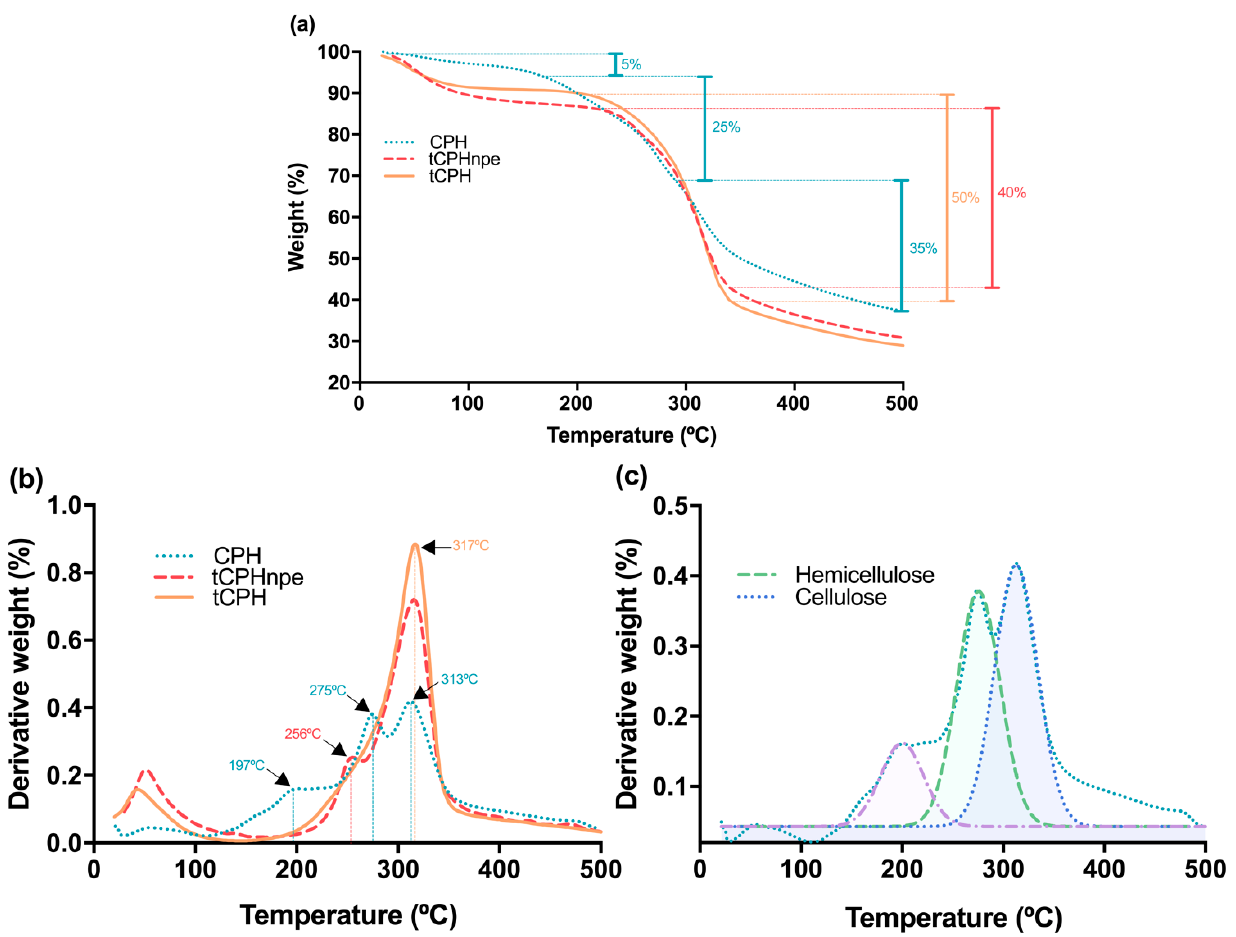
Figure 5. Thermogravimetric curves of CPH, tCPH, and tCPHnpe. ( a ) TGA curves of CPH, tCPH, and tCPHnpe, ( b ) DTGA curves of CPH, tCPH and tCPHnpe, ( c ) DTGA deconvolution for CPH fiber into separate regions of mass loss due to hemicellulose and cellulose decomposition.